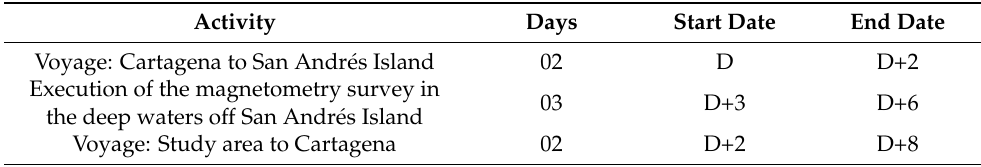
Table 2. Estimation of time of the operation, including the displacement.